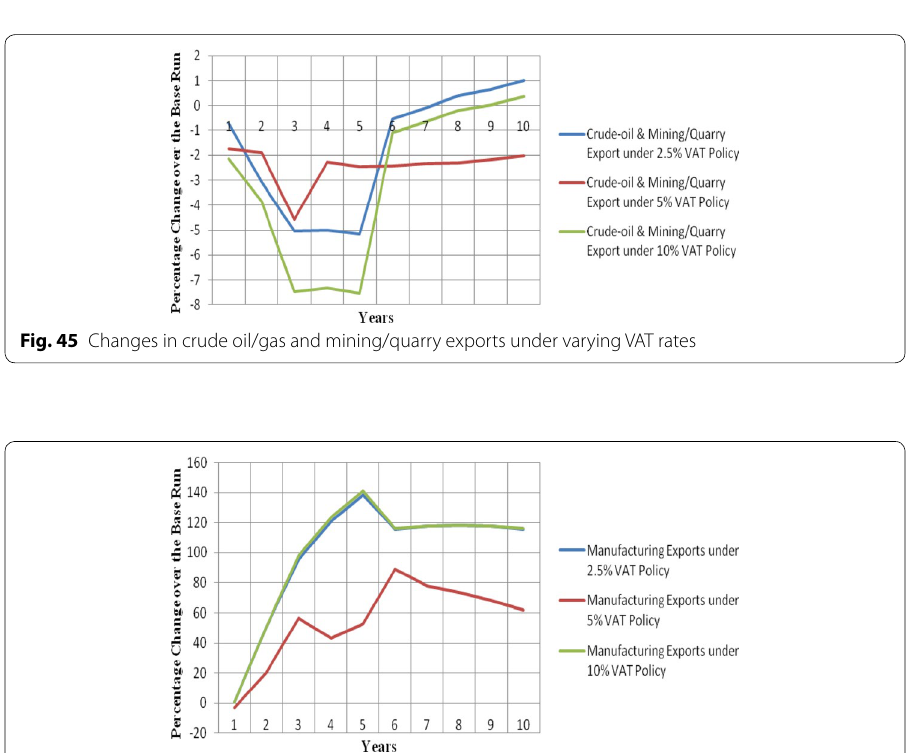
Fig. 46 Changes in manufacturing exports under varying VAT